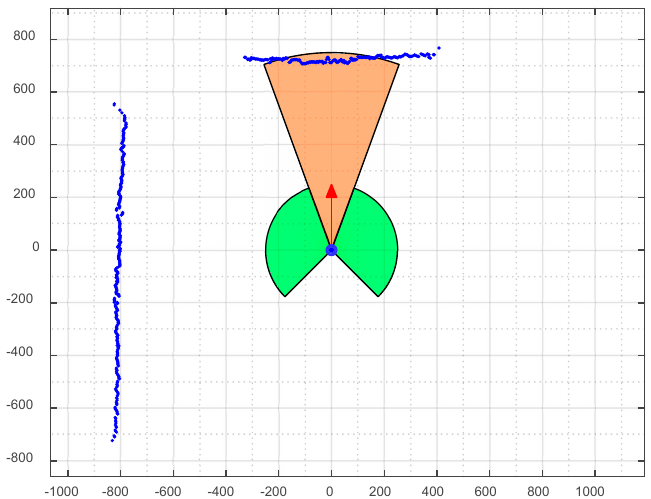
Figure 10. Depiction of the APR position and direction (red arrow), distance data points detected with the LIDAR (blue points) and depiction of the frontal (brownish) and lateral (greenish) safety areas around the mobile robot.